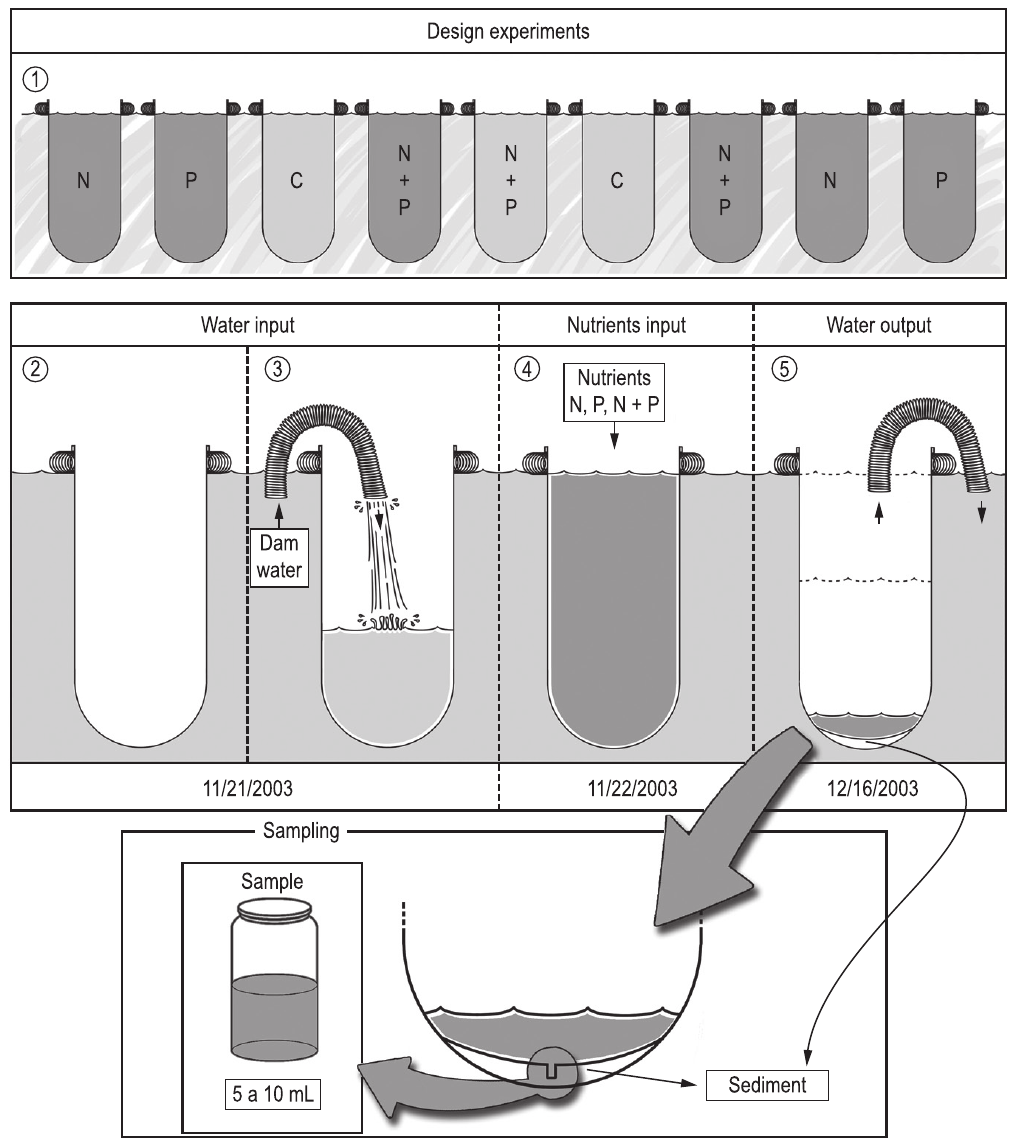
Figure 2. Schedule of the design experiments with different treatments of mesocosms installed in the Corvo river (Rosana reservoir). Stage 1 - mesocosms were randomly designed (in triplicate) with four treatments: Control (C); Nitrogen (N); phosphorus (P) and nitrogen plus phosphorus (N+P). Stage 2-3 - mesocosm were filled with water from the reservoir itself. Stage 4 - nutrients were introduced in the mesocosms. Stage 5 – In each mesocosms, after emptying carefully, samples were obtained by taking 5-10 mL from the bottom. Ilustração: C.Y. Joko, E.A. Murakami & S.A.